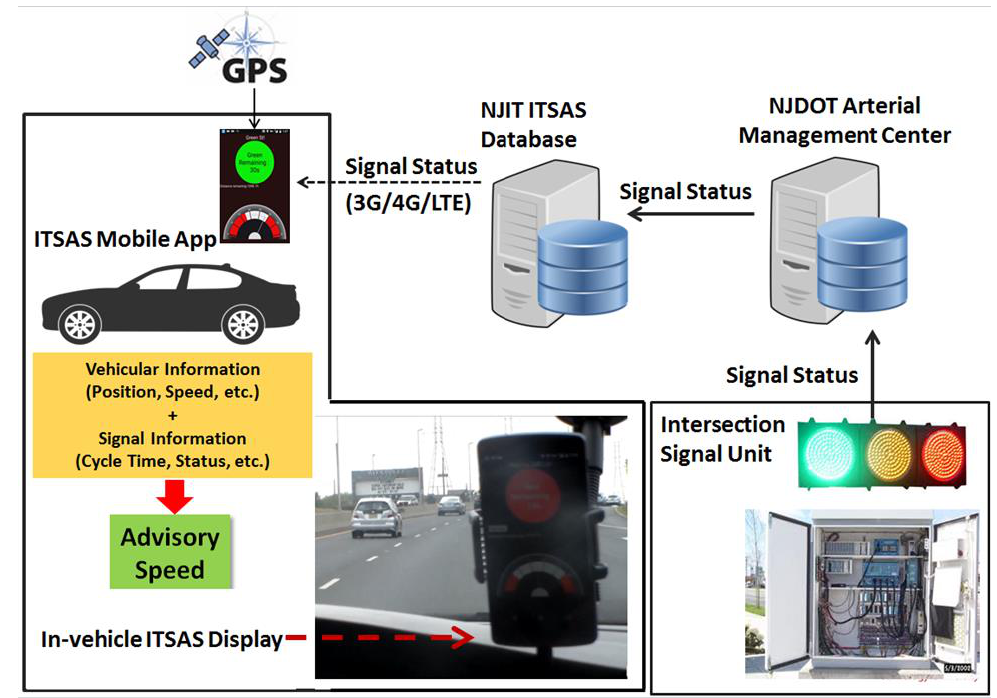
Figure 1. High-level ITSAS System Architecture.